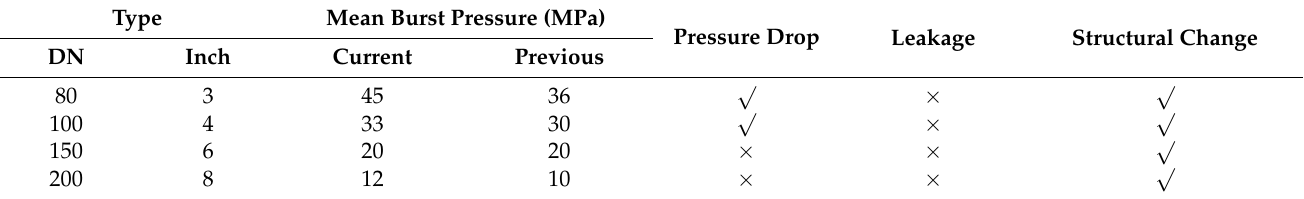
Table 4. Failure pressures of burst test with failure types and comparison with previous